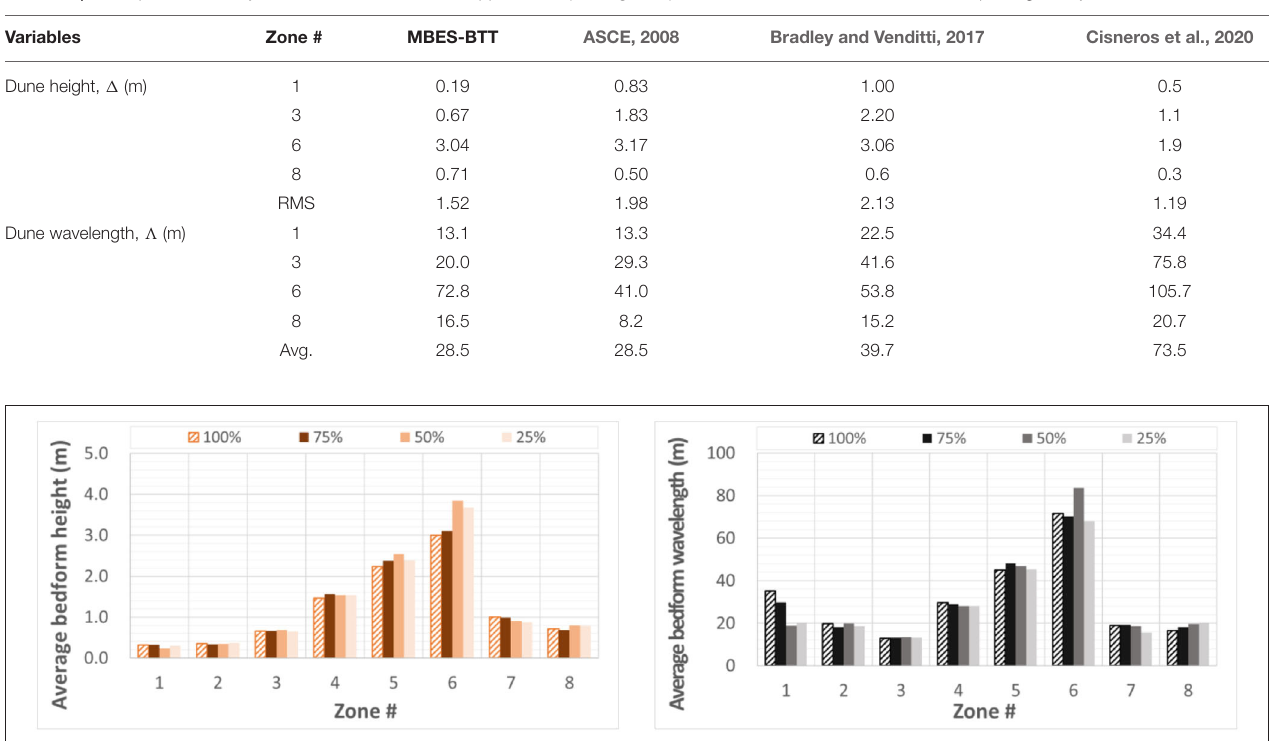
TABLE 3 | A comparison of analytical estimates for the Mississippi dataset (see Figure 2 ) with the results of MBES-BTT statistical package analysis.